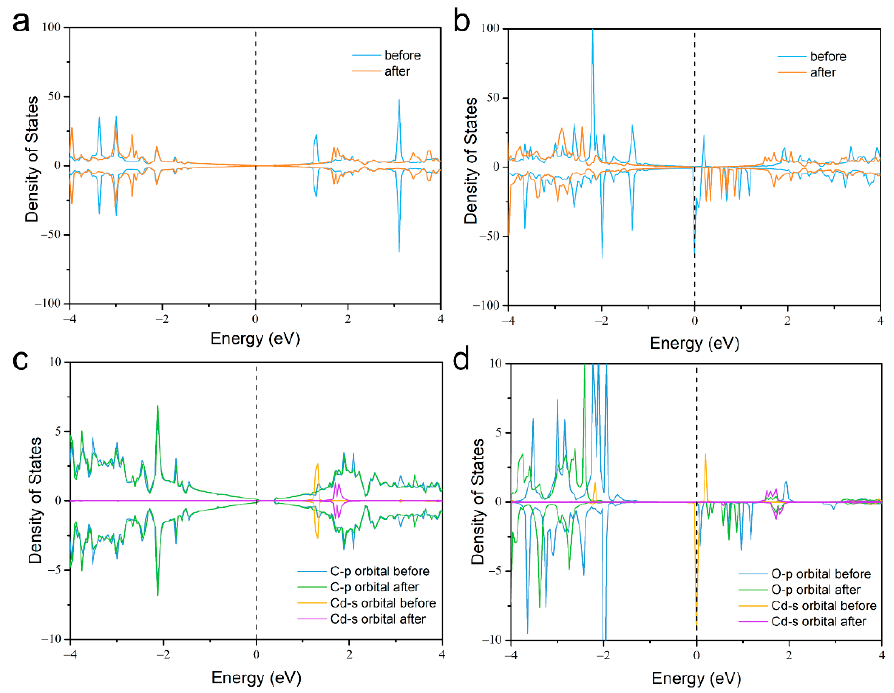
Figure 5. The density of states of CdCl 2 adsorbed on G ( a ) and Fe@G ( b ). The partial density of states of CdCl 2 adsorbed on G ( c ) and Fe@G ( d ).